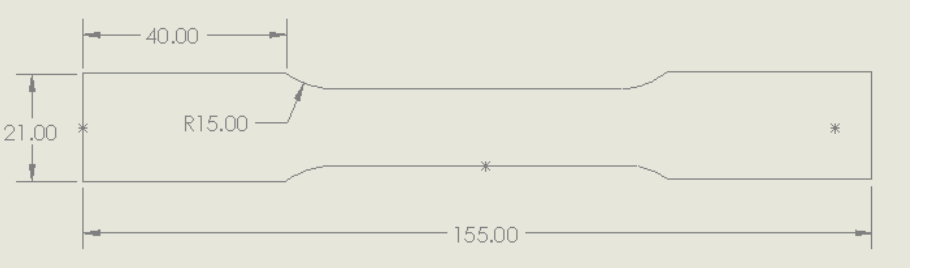
Figure 9. Experimental set-up of the R-value measurement.